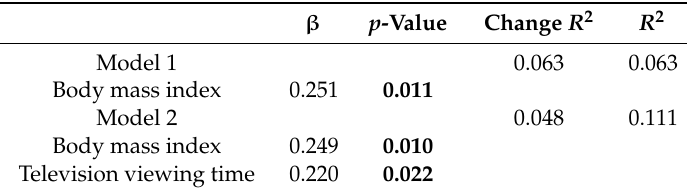
Table 3. Hierarchical stepwise regression for the association of sedentary behaviour, physical activity, cardiorespiratory fitness, and body composition parameters with sleep-related breathing disorders scale ( n = 102).